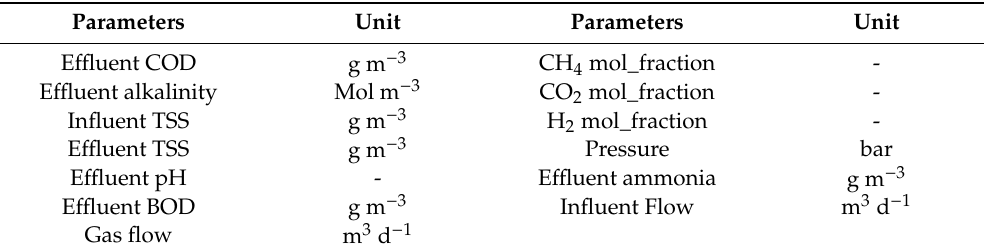
Table 1. Obtained variables from Benchmark Simulation Model No. 2